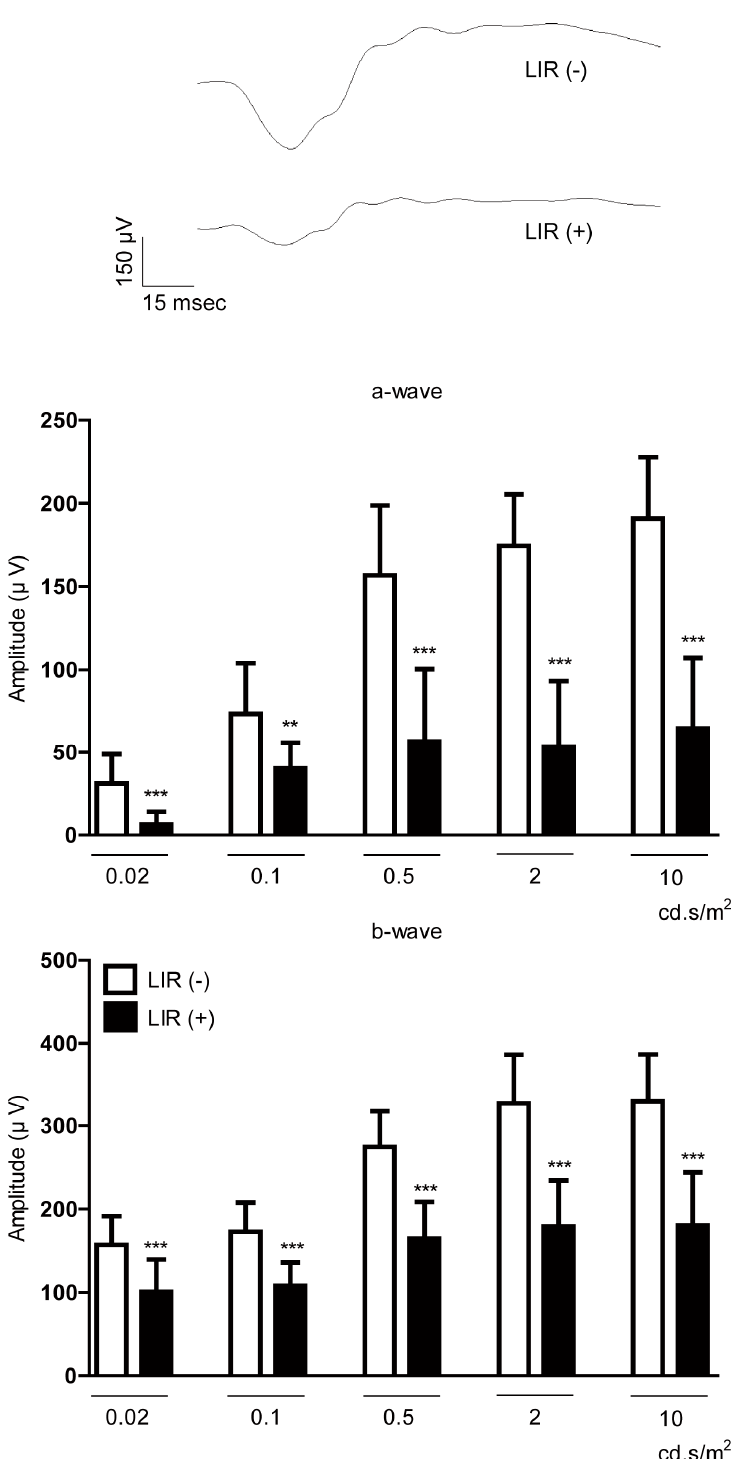
Figure A6. Evaluation of a mouse model of LIR. Representative waveforms of a ‐ and b ‐ waves (2 cd.s / m 2 ) and quantitative analyses showed that the light exposure (3000 lux) significantly decreased the amplitudes of a ‐ wave and b ‐ wave in the retina (n = 6 per group, 12 eyeballs per group). ** p < 0.01, *** p < 0.001. Bar graphs were presented as mean ± standard deviation. The data were analyzed using Student’s t ‐ test.